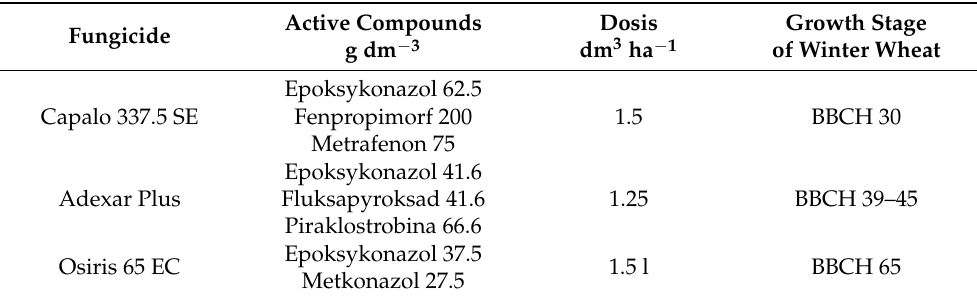
Dosis Growth Stage dm 3 ha − 1 of Winter Wheat 1.5 BBCH 30 1.25 BBCH 39–45